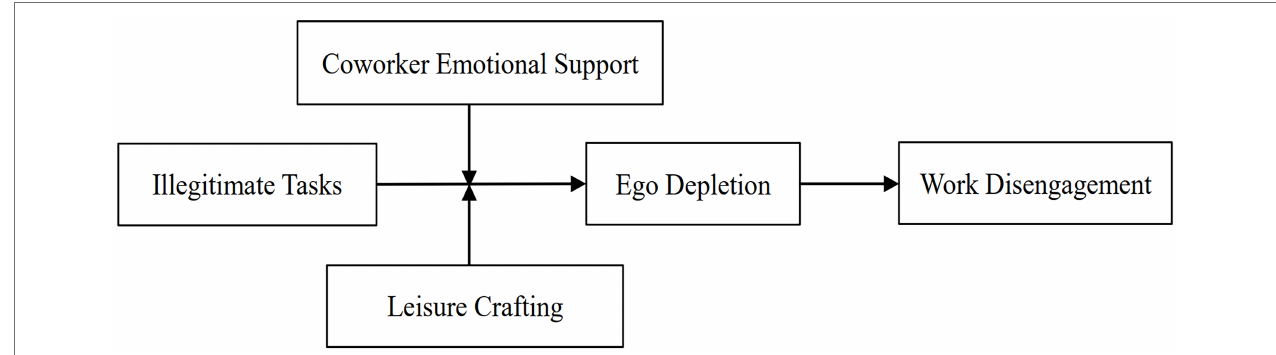
FIGURE 1 | Research conceptual